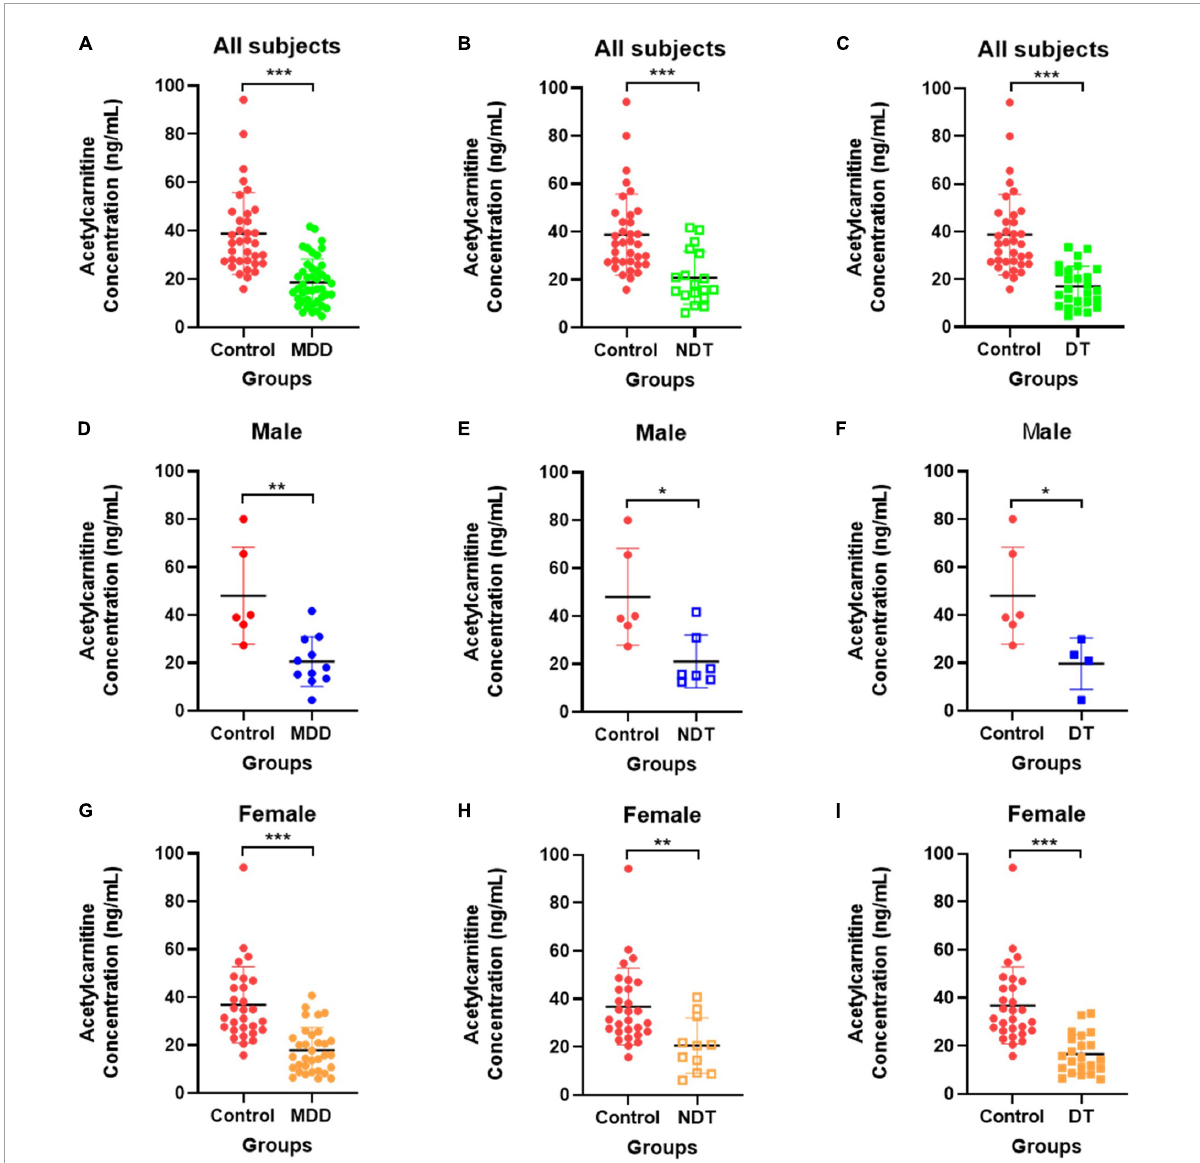
FIGURE5 Validation of acetylcarnitine. (A–C) Shows the comparison between the overall control group and the whole MDD group, (D–F) shows the comparison within males, and (G–I) shows the comparison within females. Red indicates the control group, green indicates the MDD group, blue indicates male patients, and orange indicates female patients. Patients who did not receive drug treatment are indicated by unfilled squares, and those who received drug treatment are indicated by filled squares. After the Shapiro-Wilk normality test, the difference test was performed with the Mann-Whitney test or the unpaired t -test, and the GraphPad Prism software (version 8.4.2) was used for schematics and statistical work. The values in the graph represent mean ± SD. * P < 0.05, ** P < 0.01, and *** P <